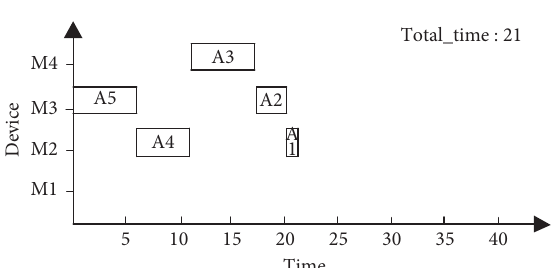
Figure 2: Process tree of product A.